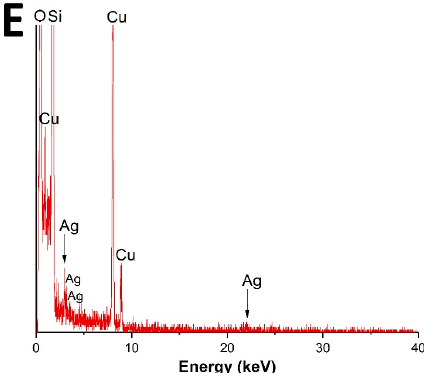
Figure 2. ( A , B ) TEM images showing spherical Ag NPs immobilized throughout the SiO 2 matrix in the raspberry-like composite at different magnifications; ( C ) The selected-area electron diffraction (SAED) ring pattern of the crystalline Ag NPs of the composite; and ( D ) the high-resolution TEM (HRTEM) image of the labeled surface-immobilized Ag NP showing the lattice fringes ( d -spacing) and the corresponding fast Fourier transform (FFT) pattern (inset); ( E ) The energy dispersive X-ray spectroscopy (EDX) elemental analysis of the Ag–SiO 2 composite.